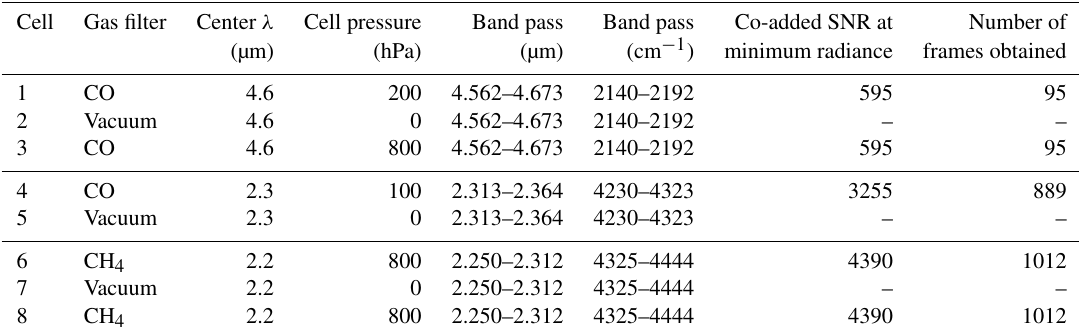
Table 1. The multi-layer dielectric optical coatings on the CHRONOS gas cell windows define the center wavelength and band pass. Each spectral coating and cell pressure is identified through modeling to provide the optimal measurement. The signal-to-noise ratio (SNR) listed provides at least a 30% margin over the SNR required to achieve radiance precision. All data frames are obtained within a single 9.7min data acquisition period.